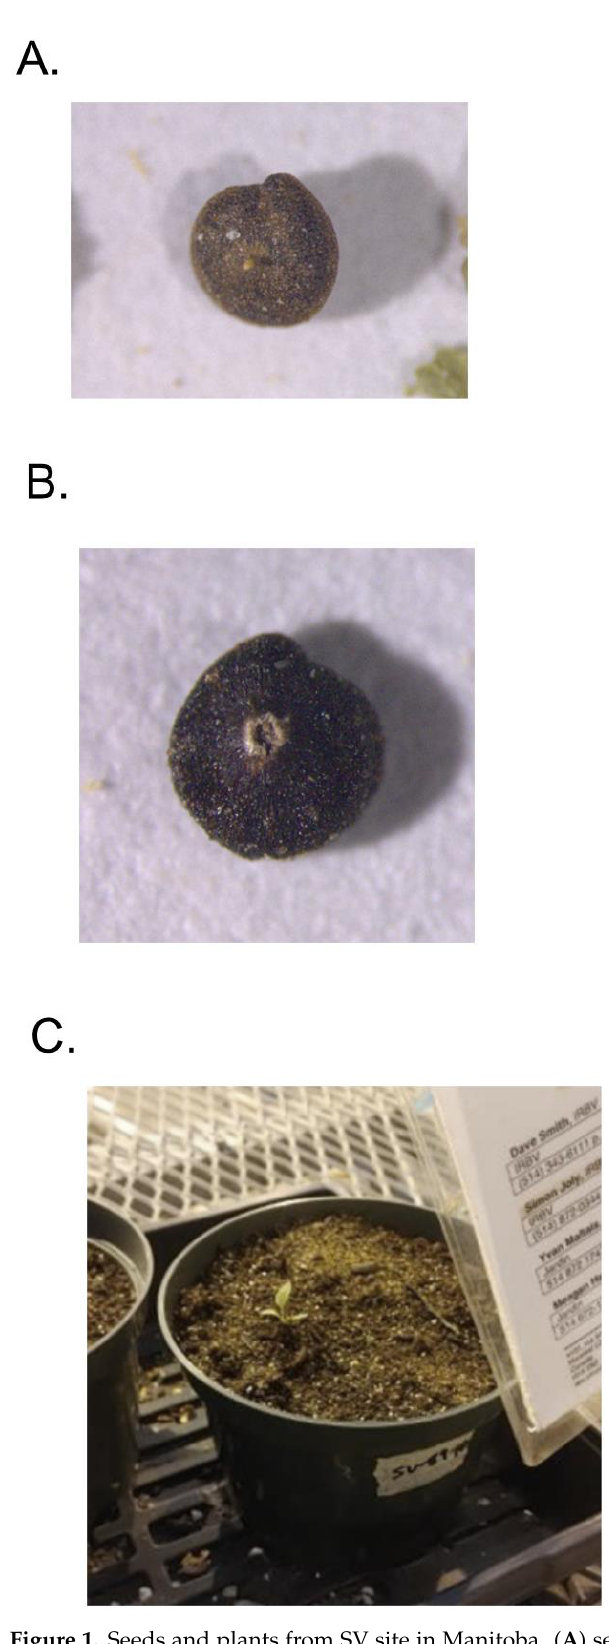
Figure 1. Seeds and plants from SV site in Manitoba. ( A ) seed from plant SV89-10. ( B ) seed from plant SV92-10. ( C ) plant from seed of plant SV89-10, at three weeks post-germination.